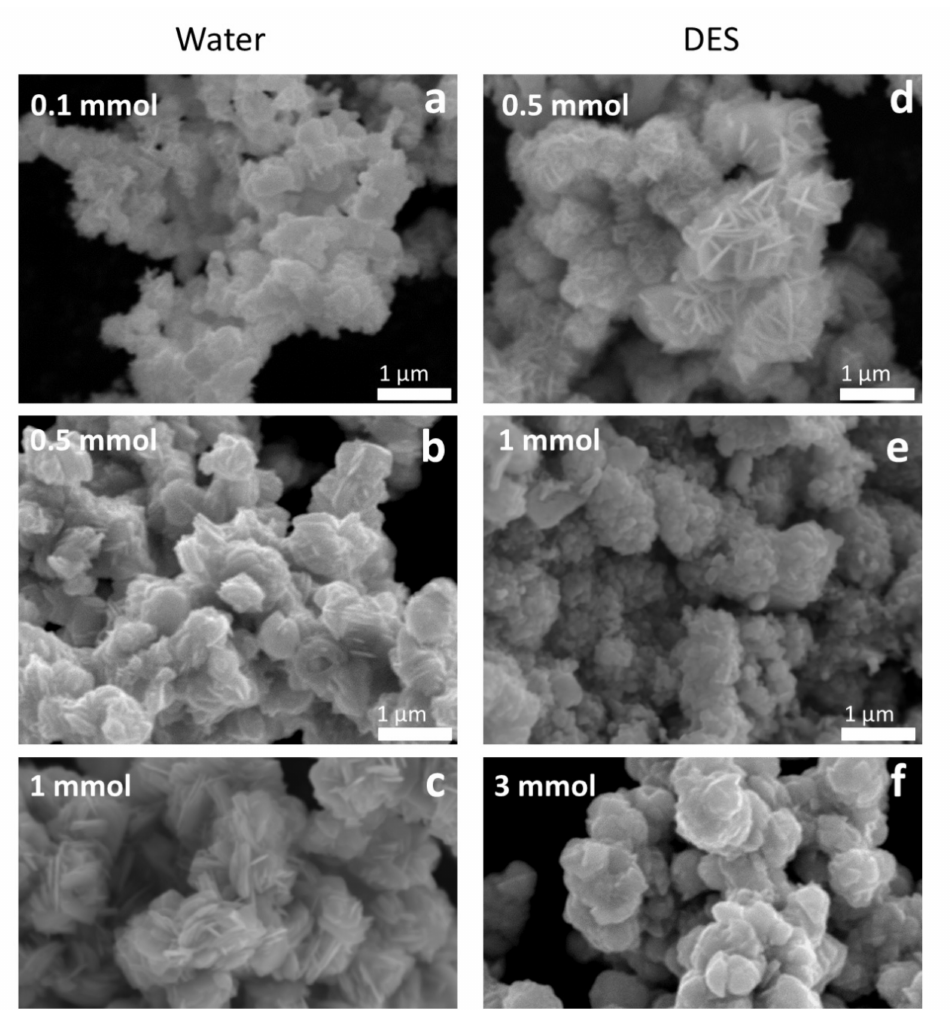
Figure 3. SEM images of the 1-step -synthesized AgInS 2 made with varying metal precursor concen- trations in water: ( a ) 0.1 mmol, ( b ) 0.5 mmol, and ( c ) 1 mmol; and in DES: ( d ) 0.5 mmol, ( e ) 1 mmol, and ( f ) 3